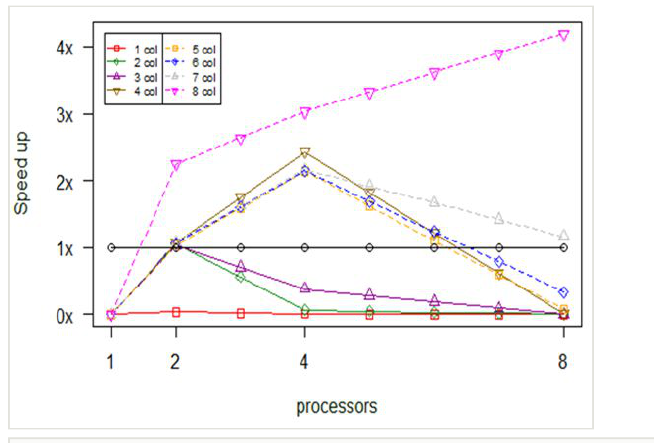
Figure 20. Computational results about optimization in bioenv's performance, depending on number of columns and number of processors